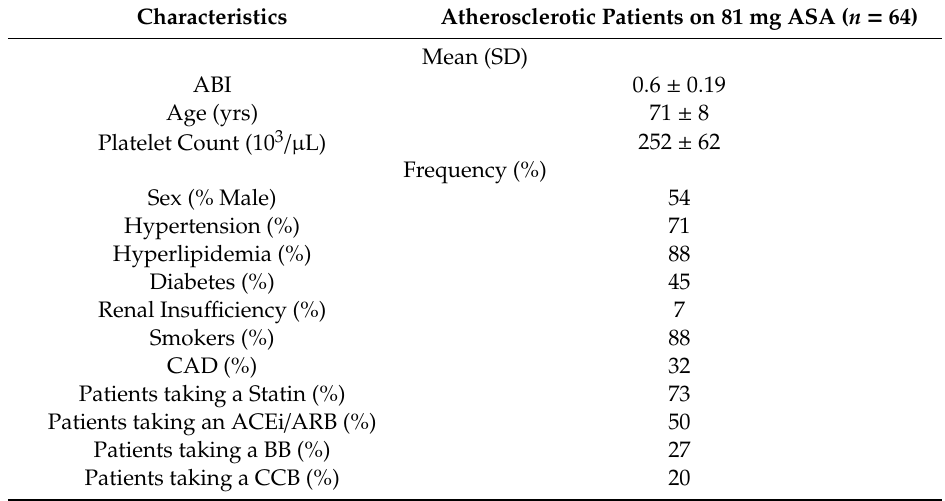
Table 1. Baseline characteristics of subjects on 81 mg ASA with documented atherosclerotic